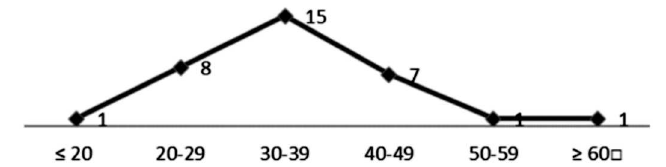
Figure 1. Age distribution of participants